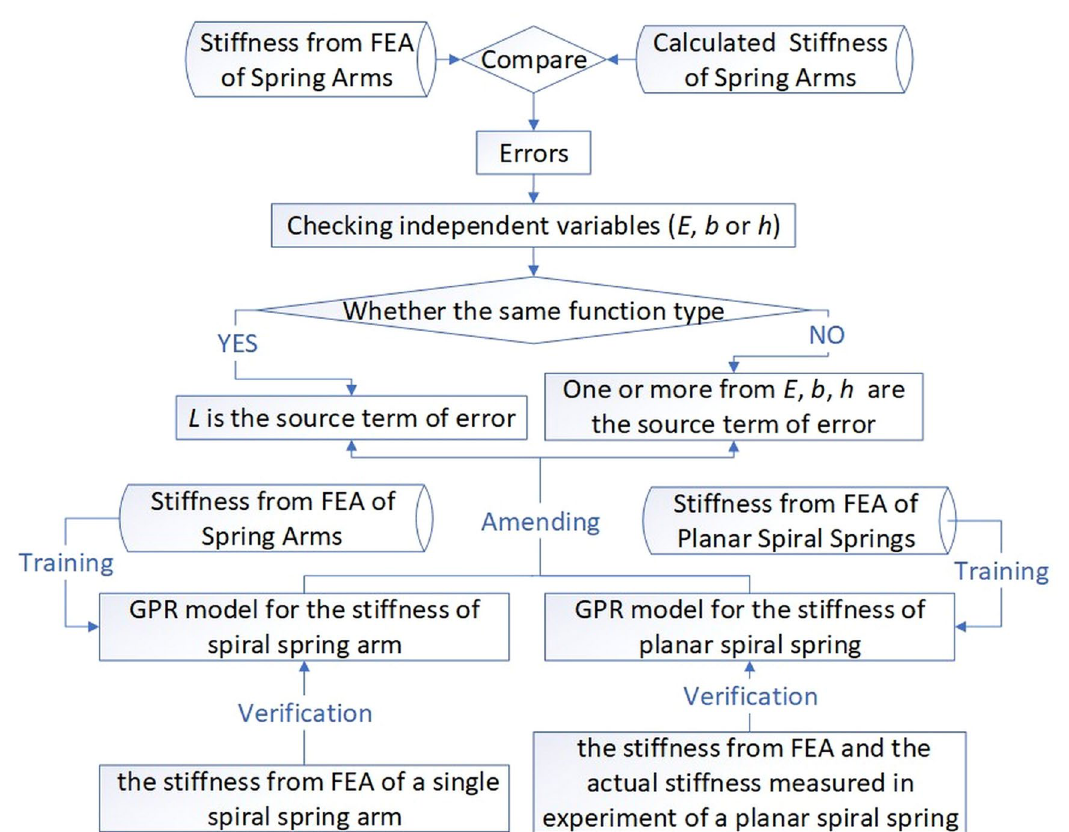
Figure 3. Flow chart of identifying the source term of error, training and verifying the GPR